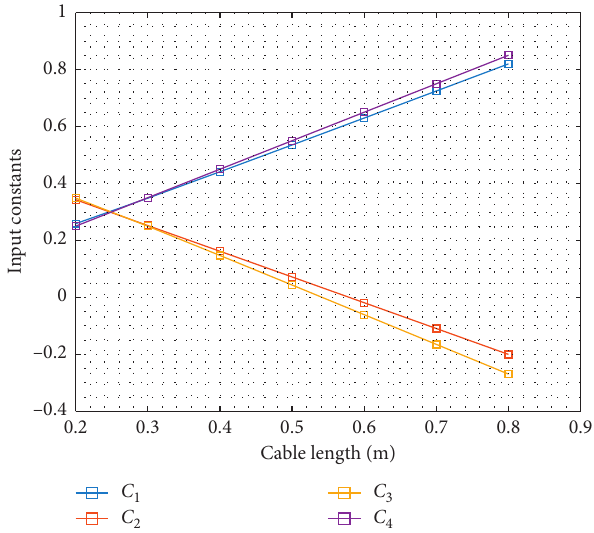
Figure 4: Input constant values versus cable lengths for the standard maneuver